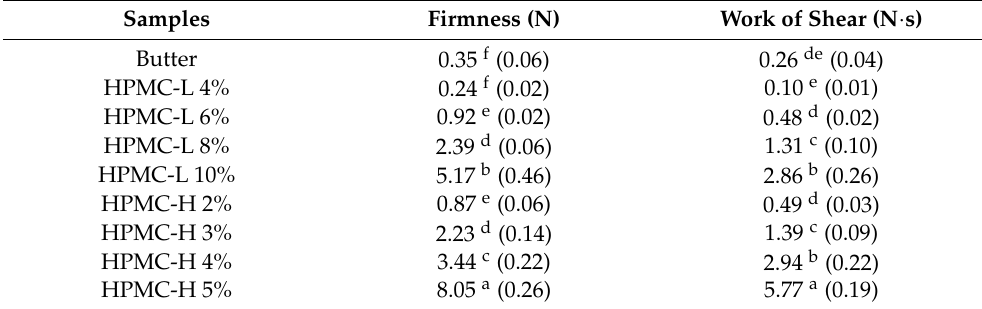
Table 2. Firmness and work of shear of different concentrations of HPMC solutions and butter.